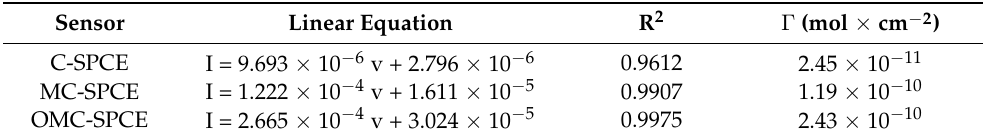
Table 3. The linear equation between I a and v, R 2 , and the concentration of the active species on the surface of the sensors.